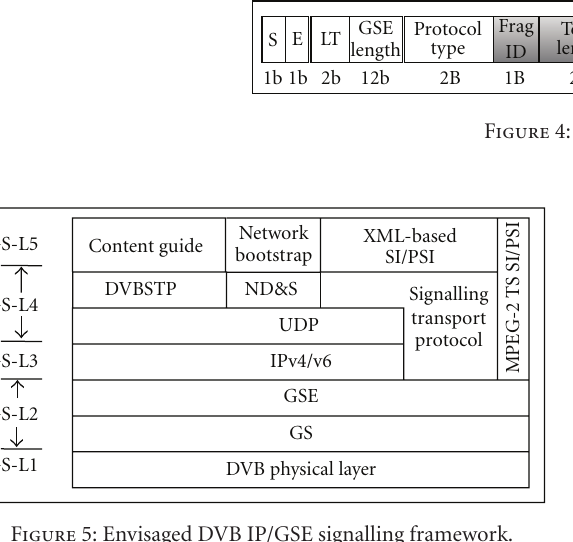
Figure 5: Envisaged DVB IP/GSE signalling